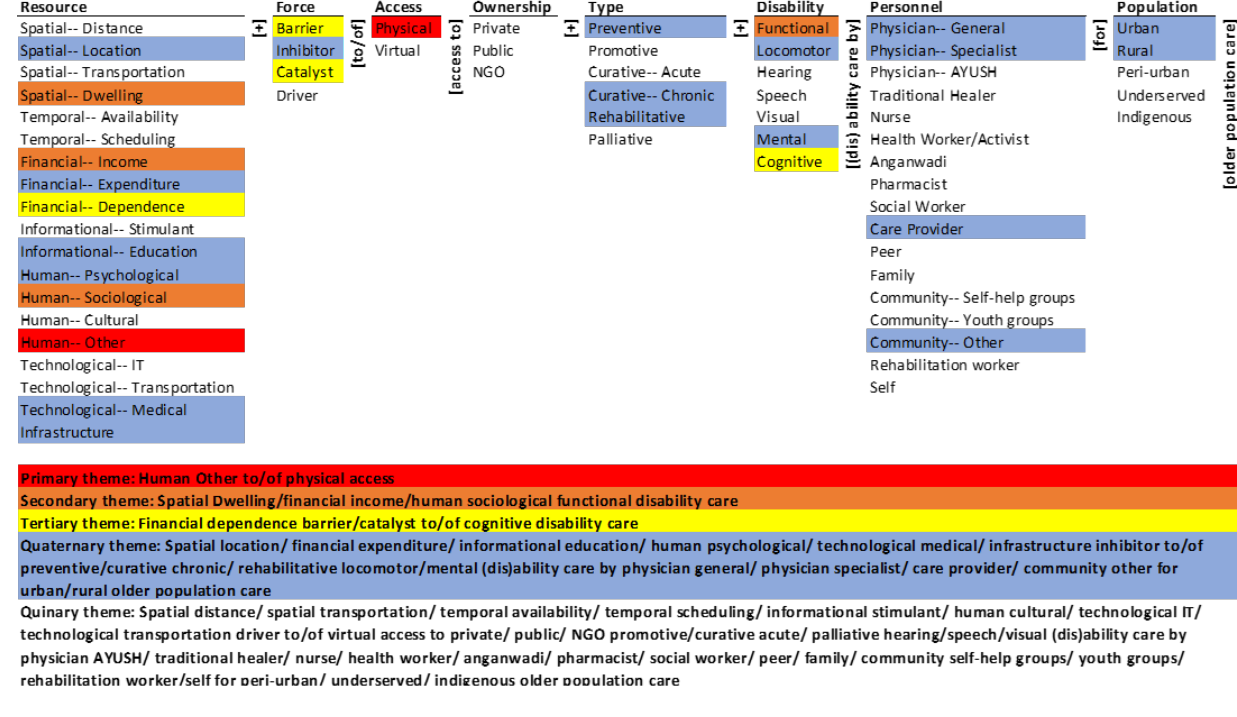
Figure 4. Theme map of access to geriatric disability care.